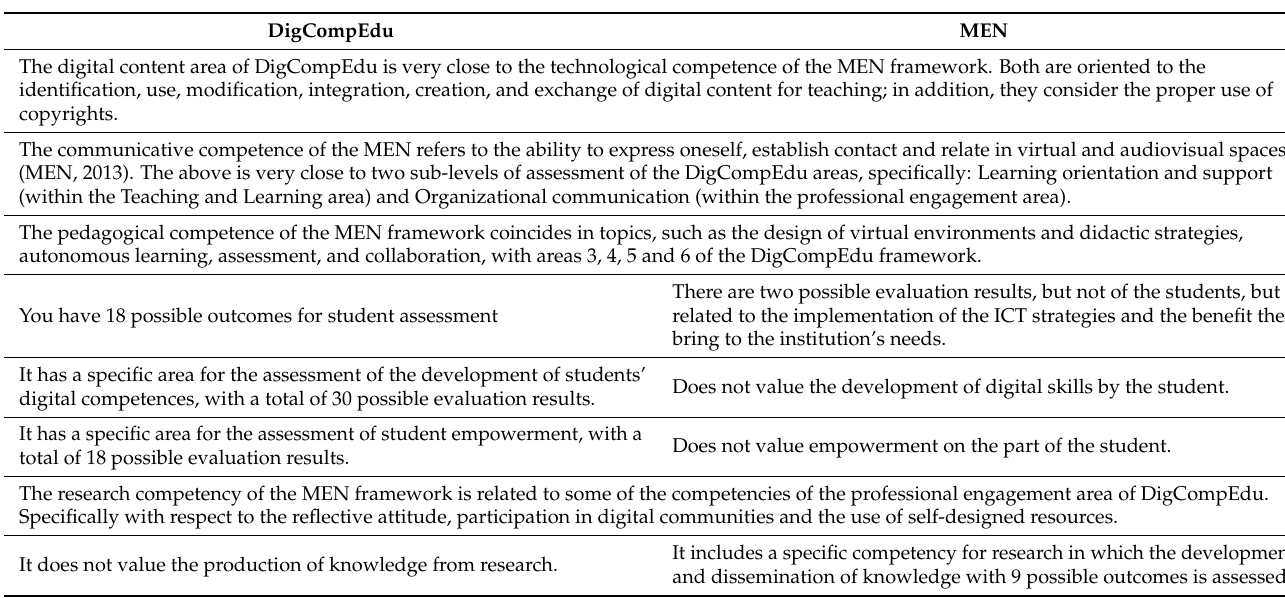
Table 12. Divergences and convergences between DigCompEdu and the MEN framework.